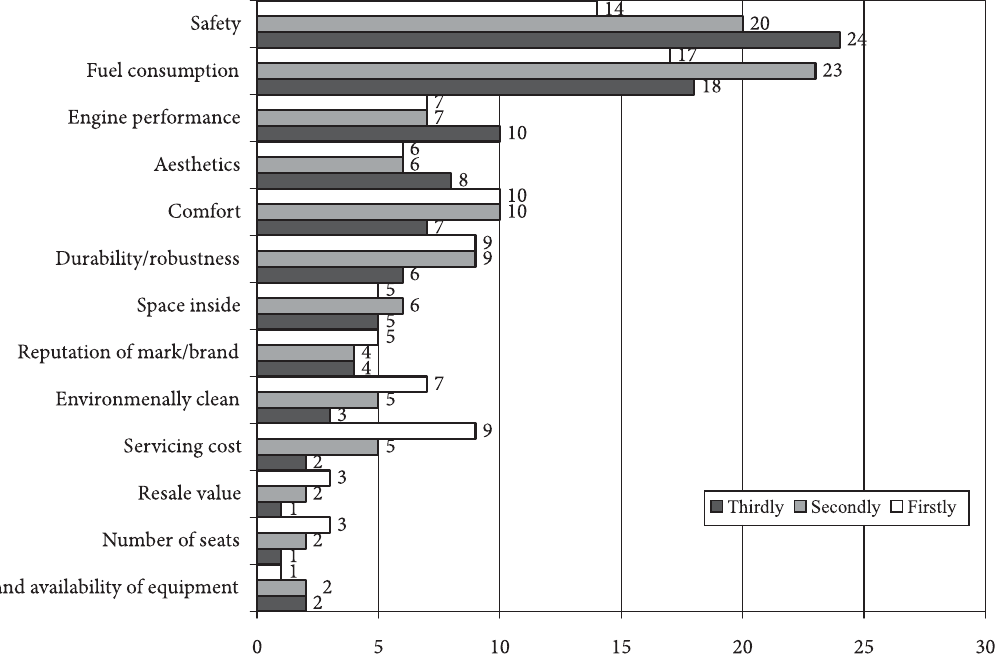
Fig. 3. Prioritisation of the factors having eff ect when choosing a car Table 1. Active and passive safety systems Aims of